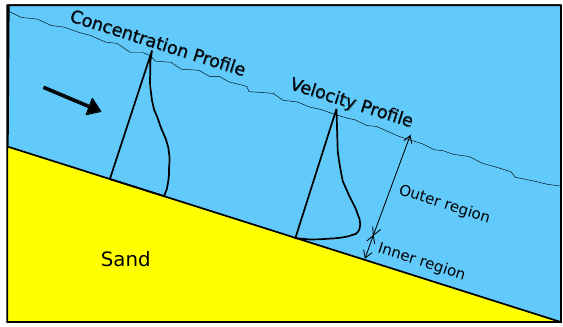
Figure 5. Typical velocity and concentration profiles of turbidity